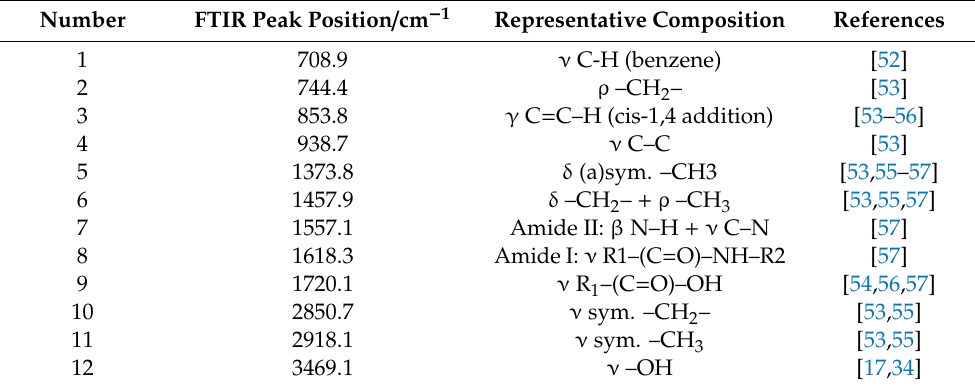
Figure 12. FT-IR spectra of WRP, 1-ODA-WRP, 2-ODA-WRP, and 3-ODA-WRP. Table 4. FT-IR peaks and representative functional group ( ν : stretching, β : in-plane bending, γ : out-of-plane bending, ω : wagging, ρ : rocking, δ : deformation, and (a)sym: (a)symmetric. ） . 395